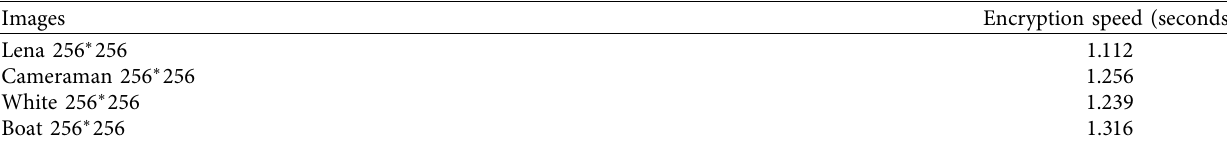
Table 13: Time taken from the proposed algorithm.